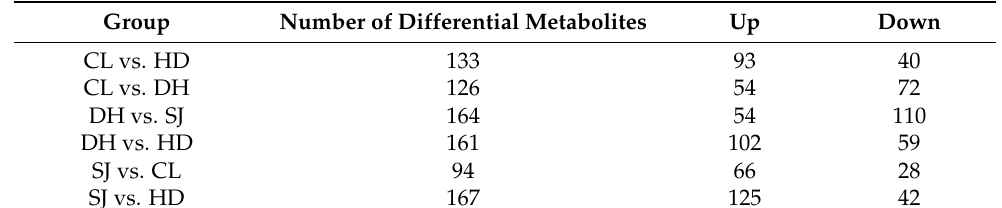
Table 1. Quantitative identification of differential metabolites.